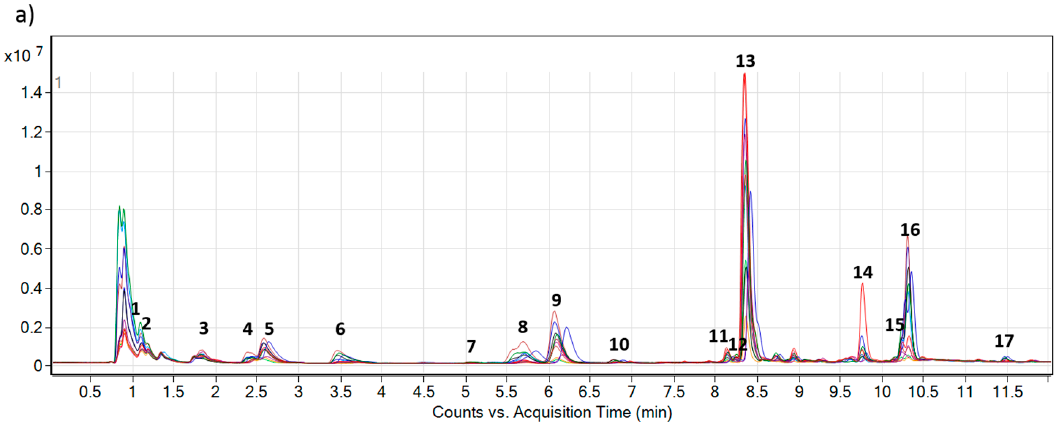
Figure 2. Cont. Figure 2. Cont .